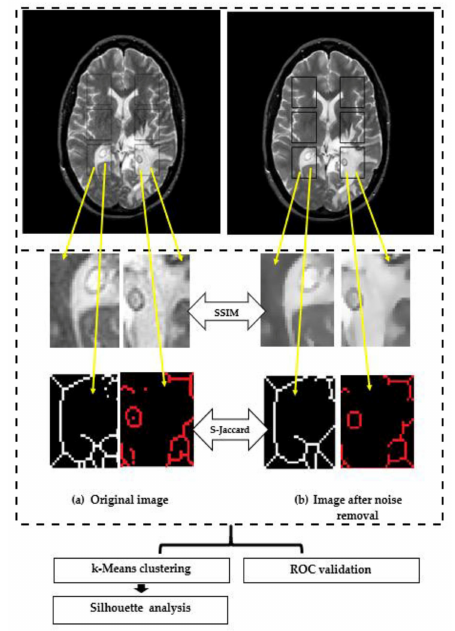
Figure 1. The proposed post-processing and